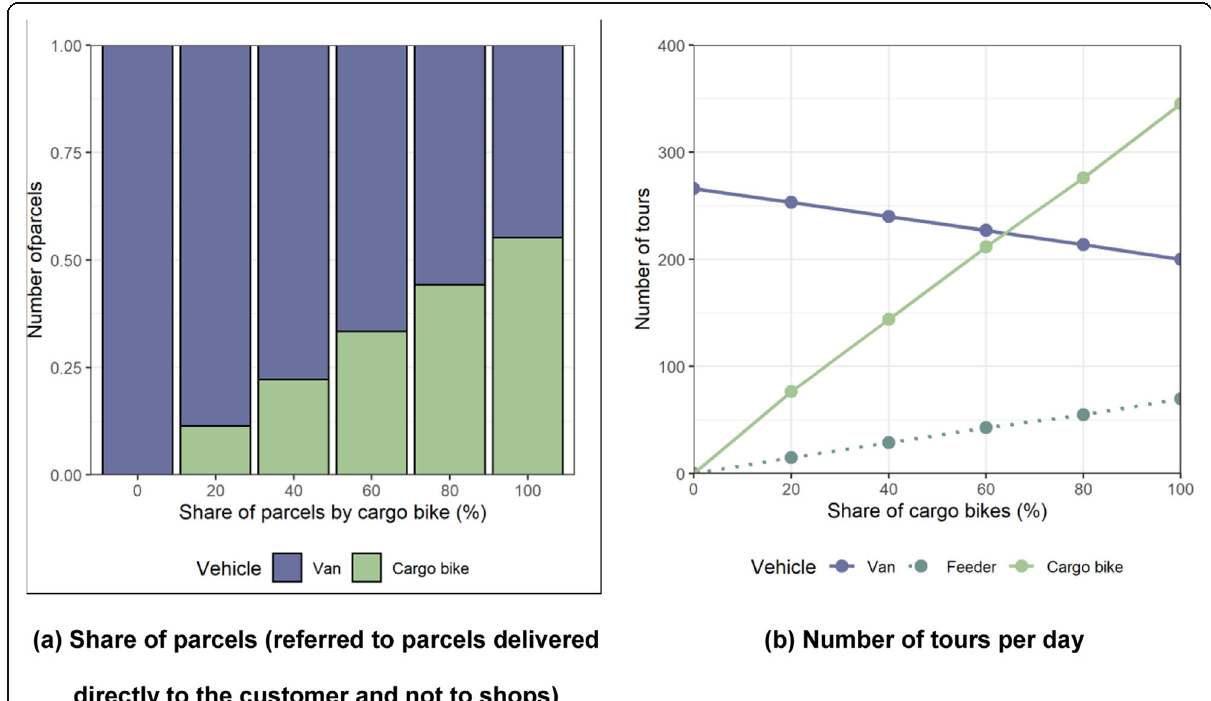
Fig. 5 General indicators for parcel distribution by vehicle